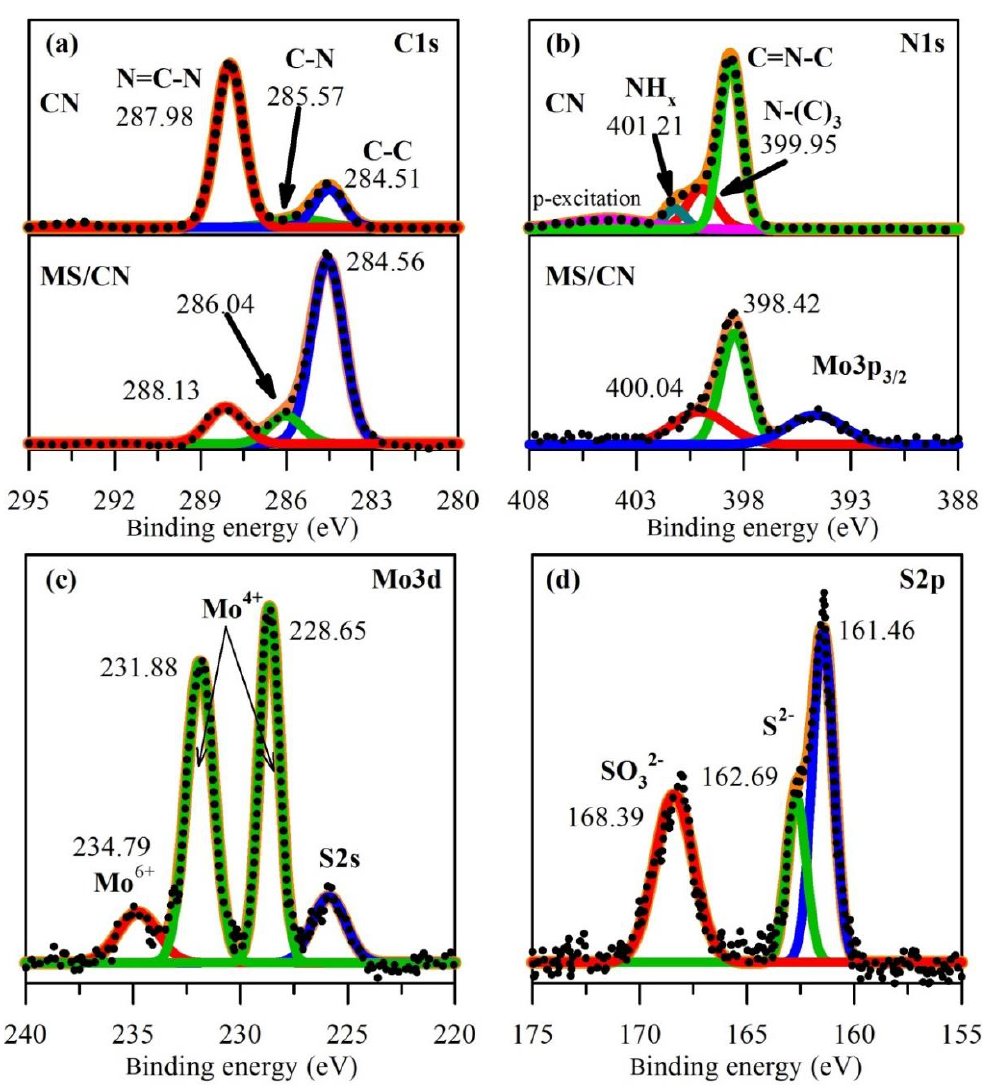
Figure 3. X-ray photoelectron spectroscopy (XPS) spectra of ( a ) C1s, ( b ) N1s for MS/CN and CN; ( c ) Mo3d and ( d ) S2p for MS/CN.